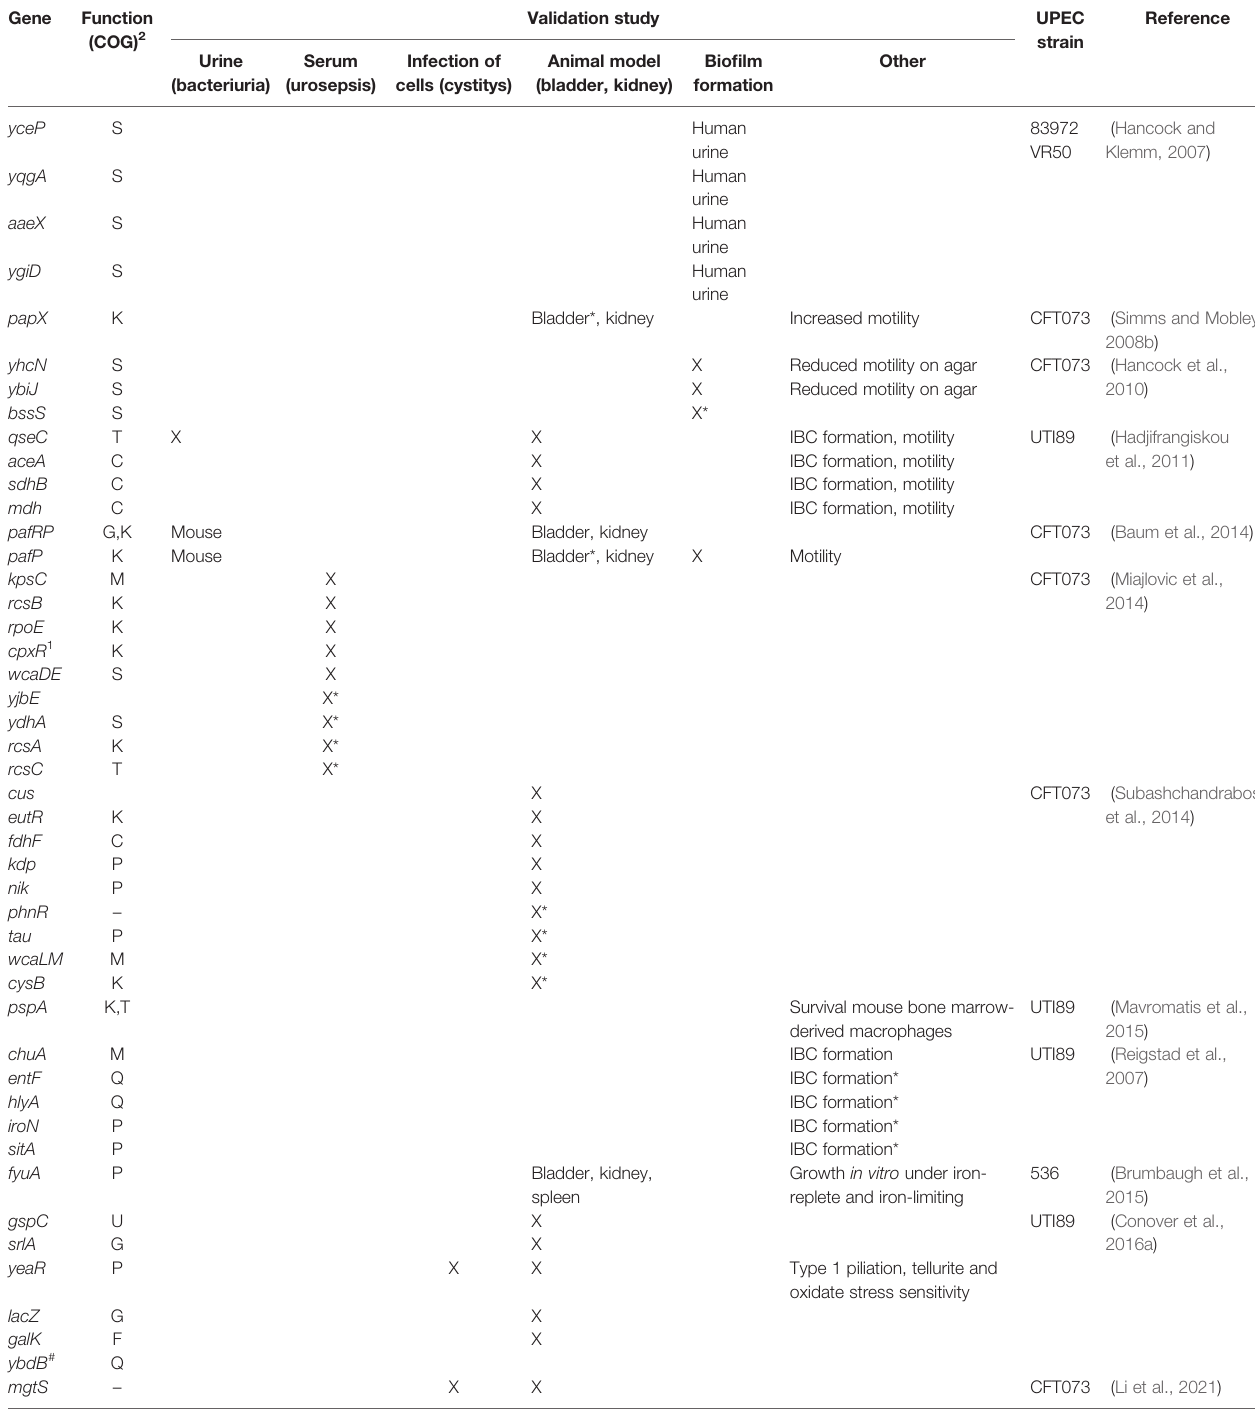
TABLE 2 | Validated genes identi fi ed by